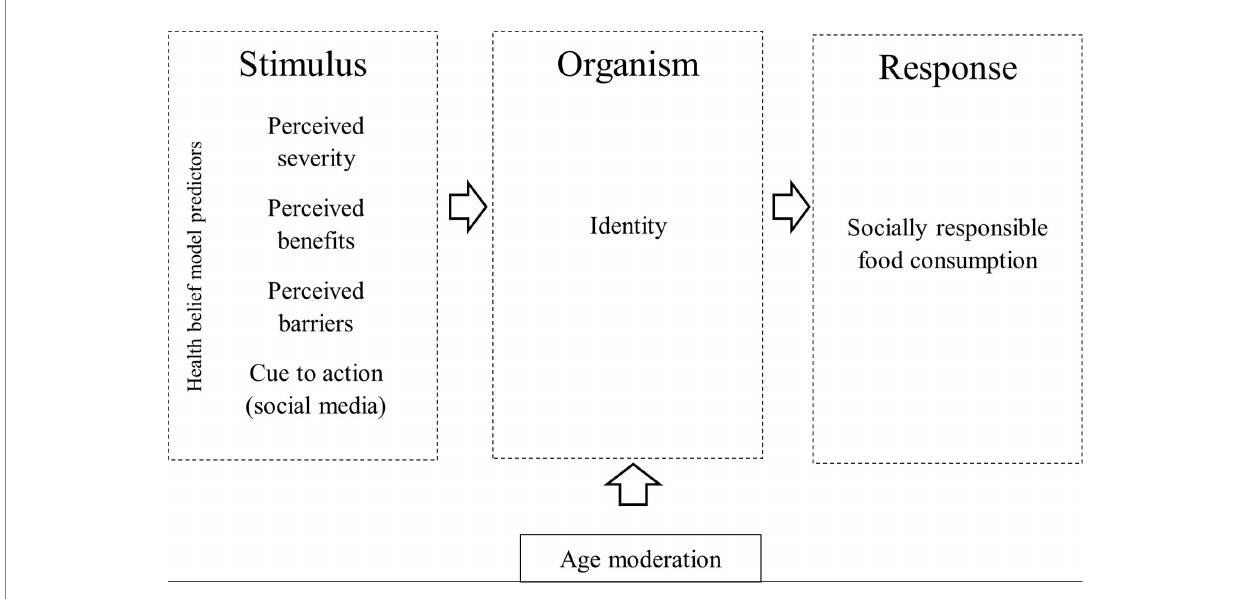
FIGURE 1 Research conceptual model.